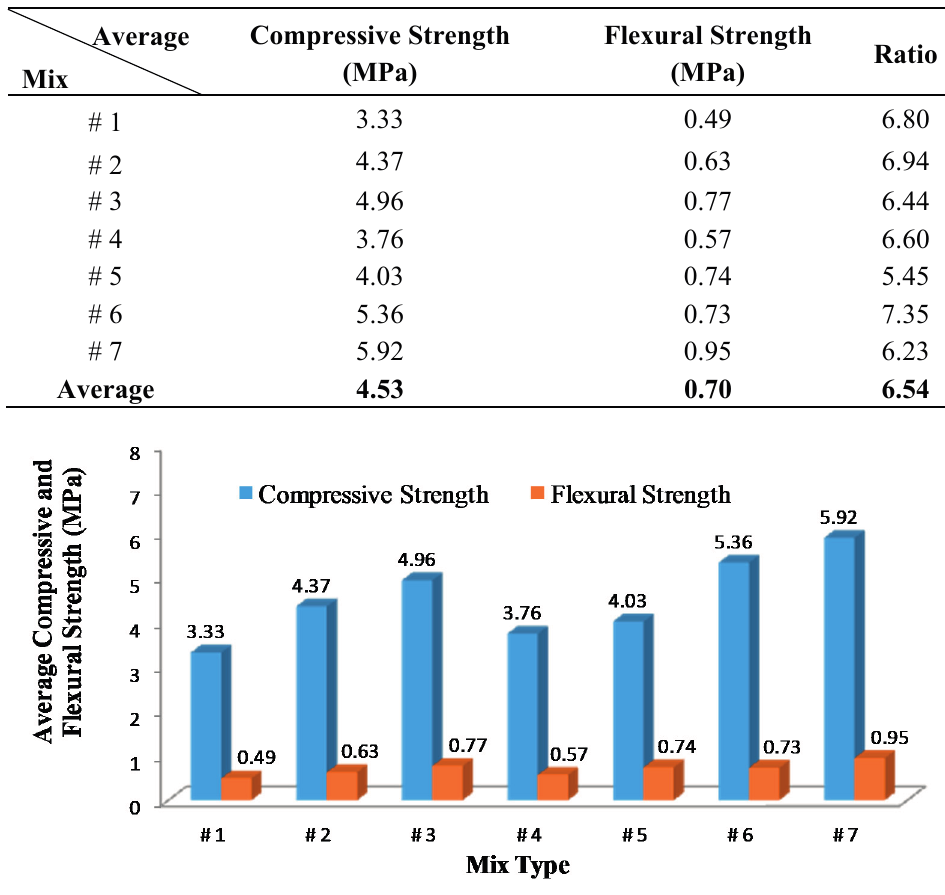
Figure 11. Average compressive and flexural